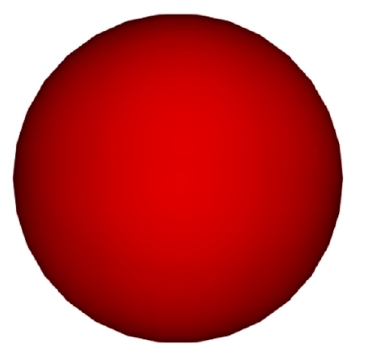
Figure 7. Triangular rigid grid on wear plate: ( a ) Section 1; ( b ) Sections 2–4.